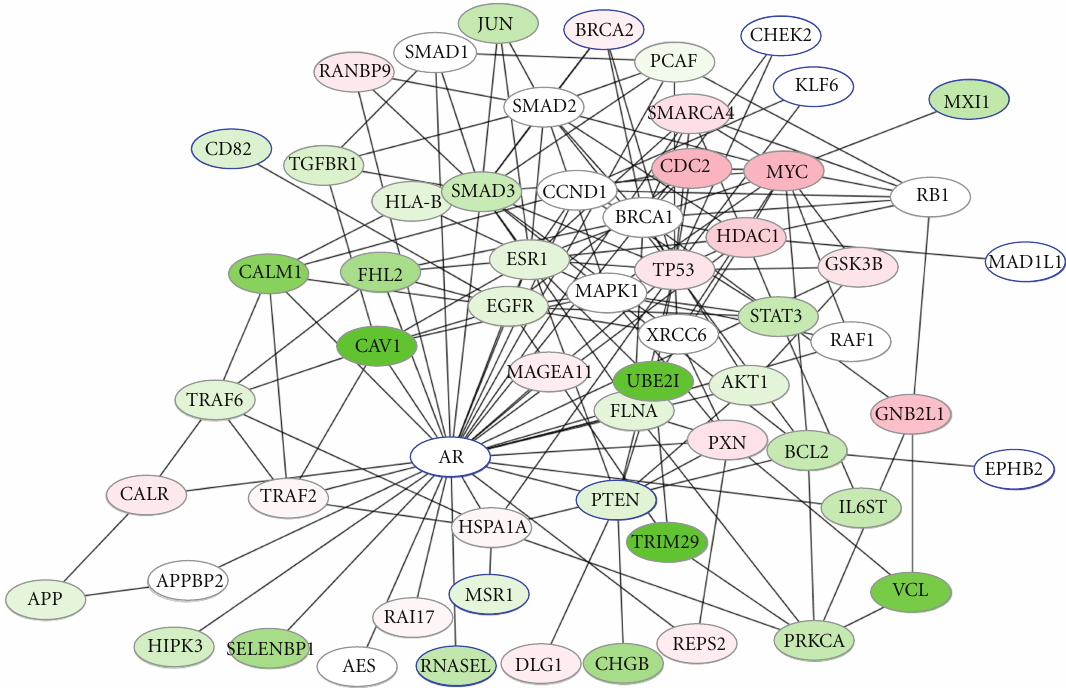
Figure 7: Prostate-normal experiment top 50 genes induced result network. Red color shows the higher di ff erence in expression between prostate cancer and normal tissue sample, on the other hand the green color shows the smaller di ff erence in expression between the samples. Nodes with node circle denote seed genes.